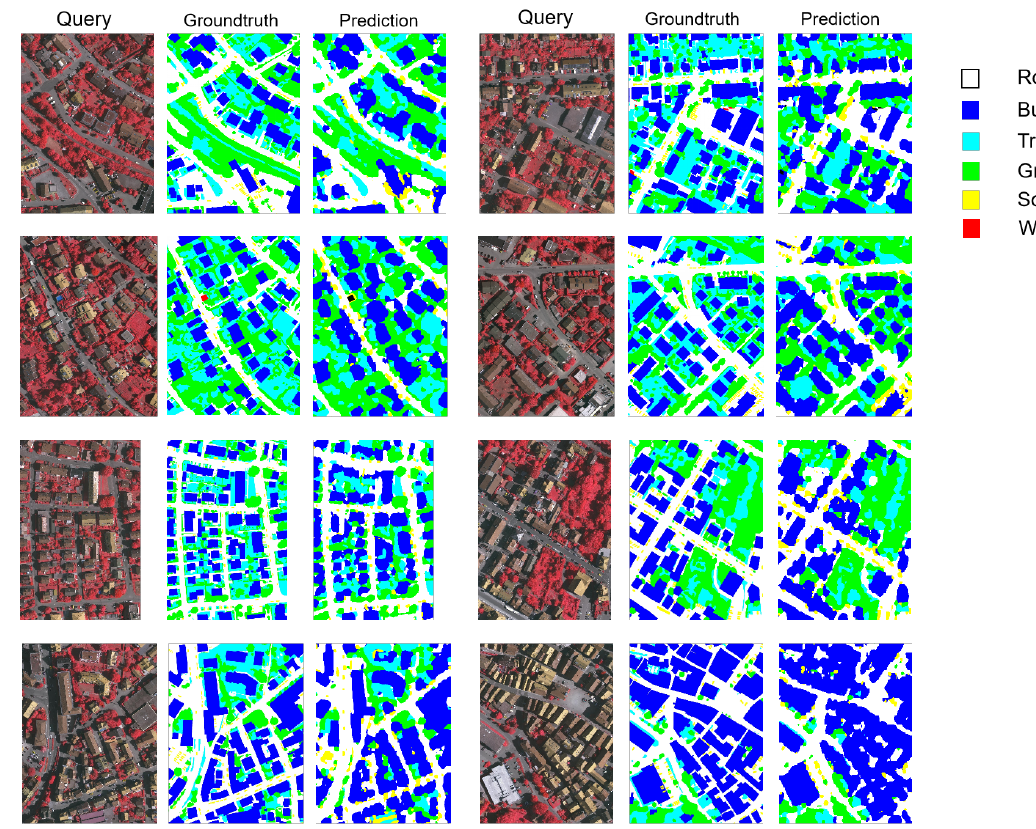
Figure 4. Qualitative outcomes of our method on Vaihingen dataset.